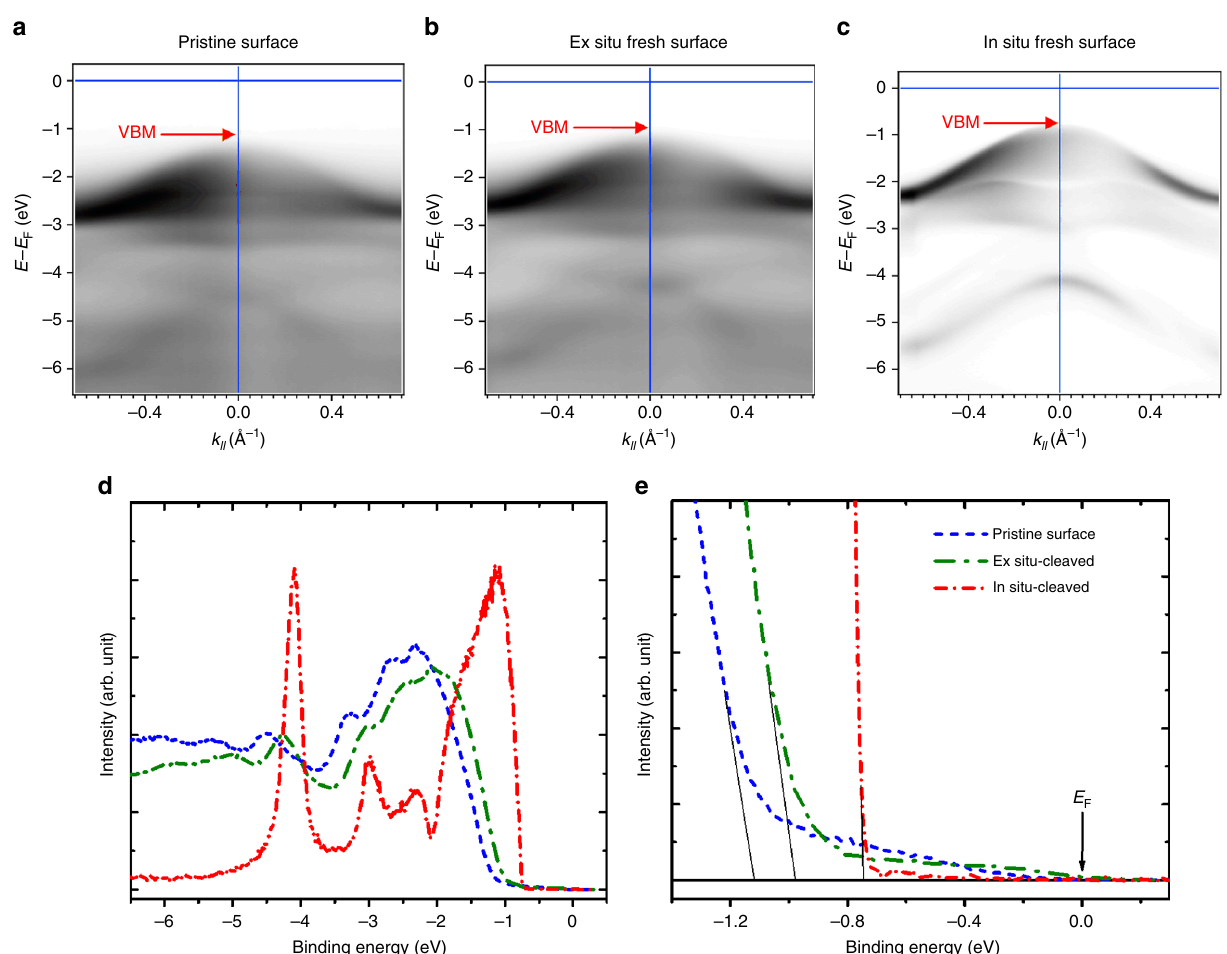
Fig. 7 ARPES characterization of pristine, ex situ and in situ-cleaved fresh surfaces of a MoS 2 single crystal. The E versus k ‖ valance band measurements for the a pristine, b ex situ, and c in situ-cleaved fresh surfaces of a MoS 2 crystal recorded with a 42-eV photon energy at 85 K. d , e The normal emission spectra at the Γ point with different binding energy scale for the pristine, ex situ fresh and in situ fresh